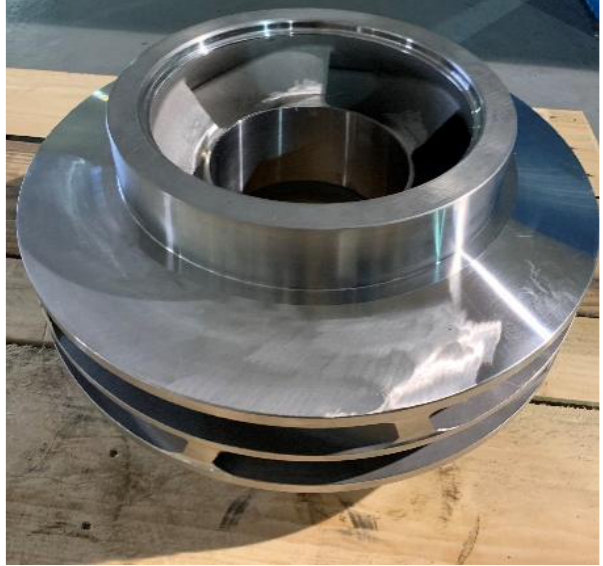
Figure 2. Real impeller. Table 1. The main design and performance parameters (pump mode, design point).